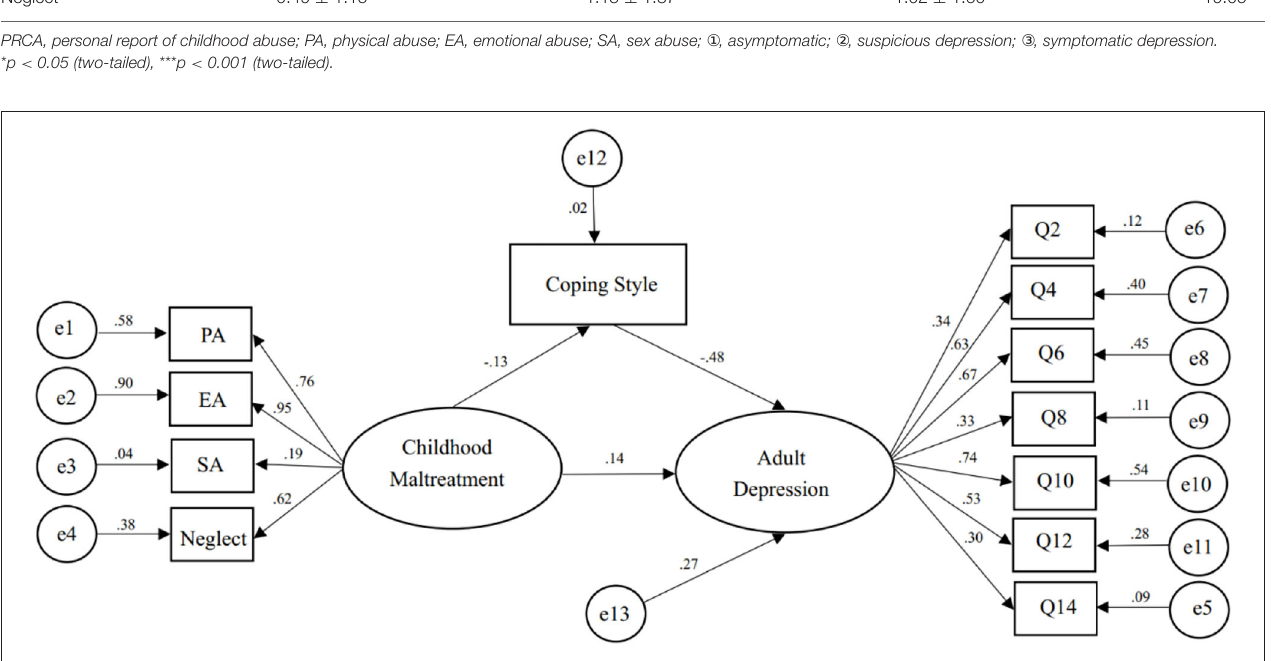
FIGURE 1 | The path model of childhood maltreatment, coping style, and adult depression.